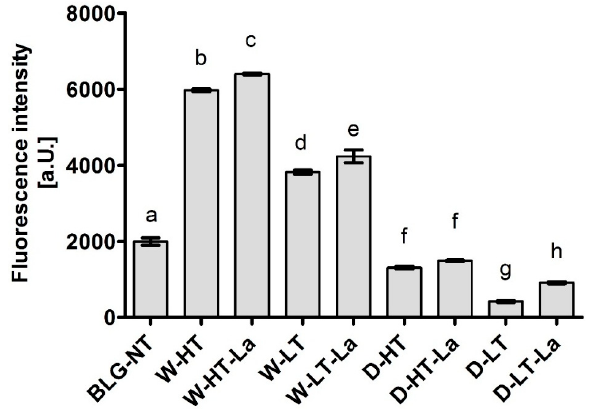
Figure 4. ThT fluorescence intensity after incubation with BLG heated in the absence of lactose or in the presence of lactose (La) in a wet system (W) or a dry system (D) under low temperatures (LT) or high temperatures (HT). BLG-NT: unheated BLG. Error bars represent standard deviation of technical duplicates. Letters indicate significant differences between the BLG groups. p -values < 0.05 are considered statistically significant, as analyzed with one-way ANOVA and Tukey post hoc comparison test (SPSS).